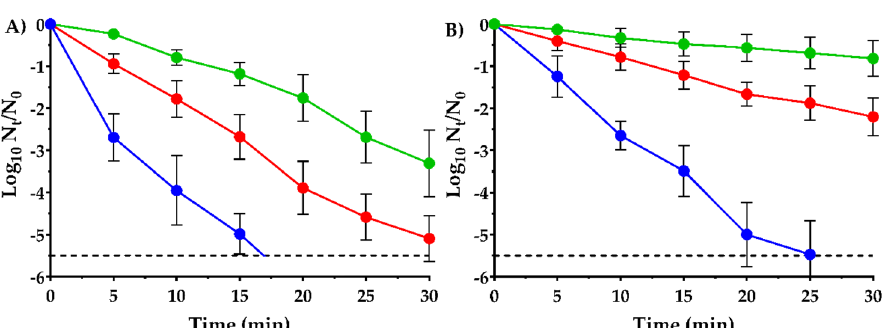
Figure 5. Survival curves of Salmonella enterica subsp. enterica serovar Typhimurium LT2 wild type ( • ); SeWT) and evolved strains: SeSCar ( • ); by cyclic exposure to prolonged sublethal treatments of carvacrol) and SeLCar ( • ); by cyclic exposure to short lethal treatments of carvacrol), after 150 µ L / L carvacrol treatment at pH 4.0 ( a ) and pH 7.0 ( b ). Data are means ± standard deviations (error bars) obtained from at least 3 independent experiments. The dashed line represents the detection limit ( − 5.5 log 10 N t / N 0 ).